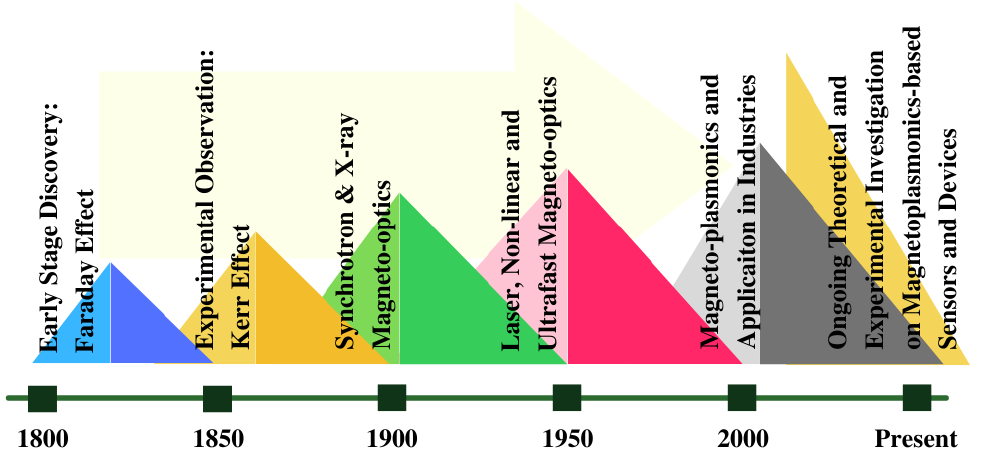
Figure 9. The origin of magneto-optics and emerging trends. 1800–1850: Early-Stage Discovery [1,145,146]: Faraday Effect; 1850–1900: Experimental Observation of the Kerr Effect [147]; 1900–1950: Synchrotron & X-ray Magneto-Optics [148]; 1950–2000: Laser, Non-linear and Ultra-fast Magneto-Optics [149]; and 2000–Present: Magnetoplasmonics [15,53,74,129,150,151], all-dielectric magnetophotonics [24,25, 32,33,35,42,124], and industrial Applications